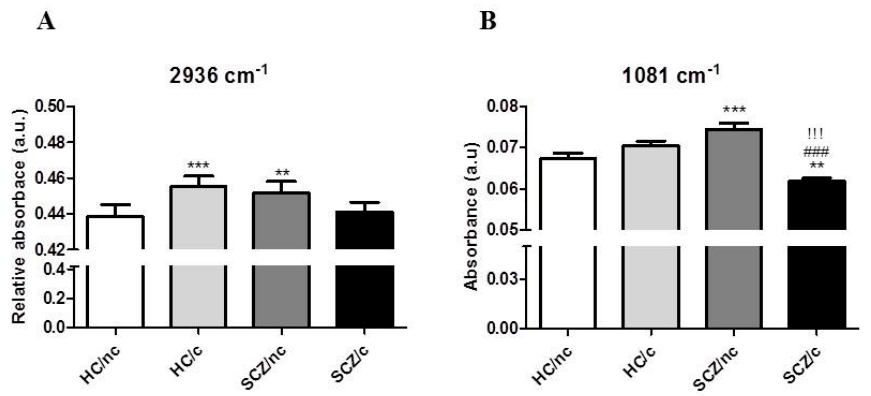
Figure 4. Peak amplitudes for the methylation related peak 2936 cm-1 ( A ) and the symmetric stretching vibrations of the phosphate group (1081 cm-1) ( B ) in ON cells from healthy controls non-cannabis users (HC/nc); healthy controls cannabis users (HC/c); schizophrenic patients non-cannabis users (SCZ/nc) and schizophrenic patients cannabis users (SCZ/c). The data are expressed as means ± S.E.M. * p < 0.05; ** p < 0.01; *** p < 0.001 vs. HC/nc. ! p < 0.05; !! p < 0.01; !!! p < 0.001 HC/c vs SCZ/nc. # p < 0.05; ## p < 0.01; ### p < 0.001 SCZ/nc vs SCZ/c.